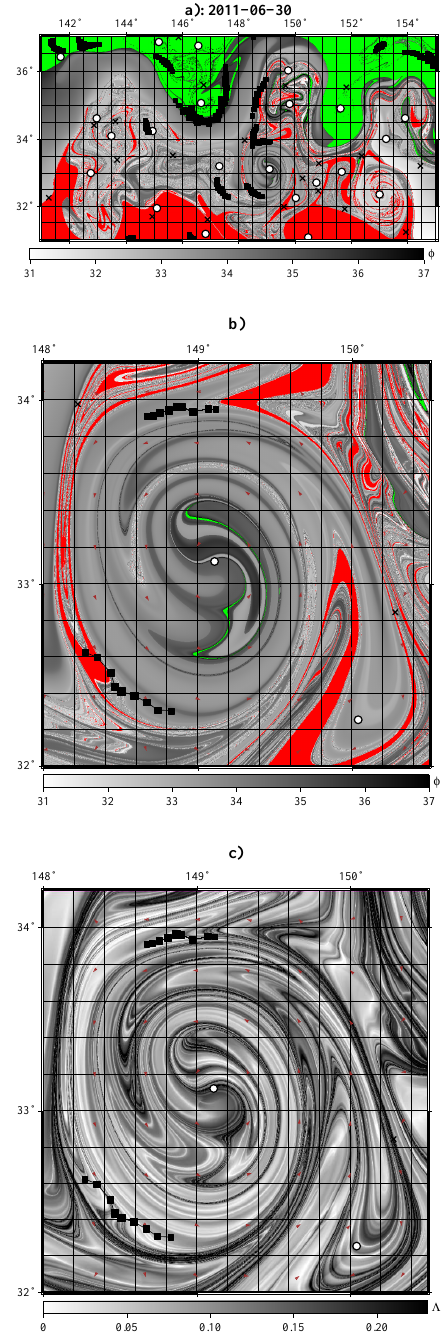
Fig. 3. (a) Lagrangian latitudinal map on 30 June 2011 computed from that date to the day of the accident, 11 March 2011, with “red” and “green” particles that originated from the latitudes < 31 and > 37 ◦ N, respectively. Nuances of the grey color in geographic de- grees code the particles that originated from the latitudes between 31 and 37 ◦ N. (b) Zoom of the area with the CR1 demonstrates transport across the KE jet (“green” particles). Tracks of two drifters to be trapped by the CR1 are shown as black squares. Crosses and open circles mark “instantaneous” hyperbolic and elliptic stagna- tion points, respectively. (c) Lyapunov map of the same area as in (b)